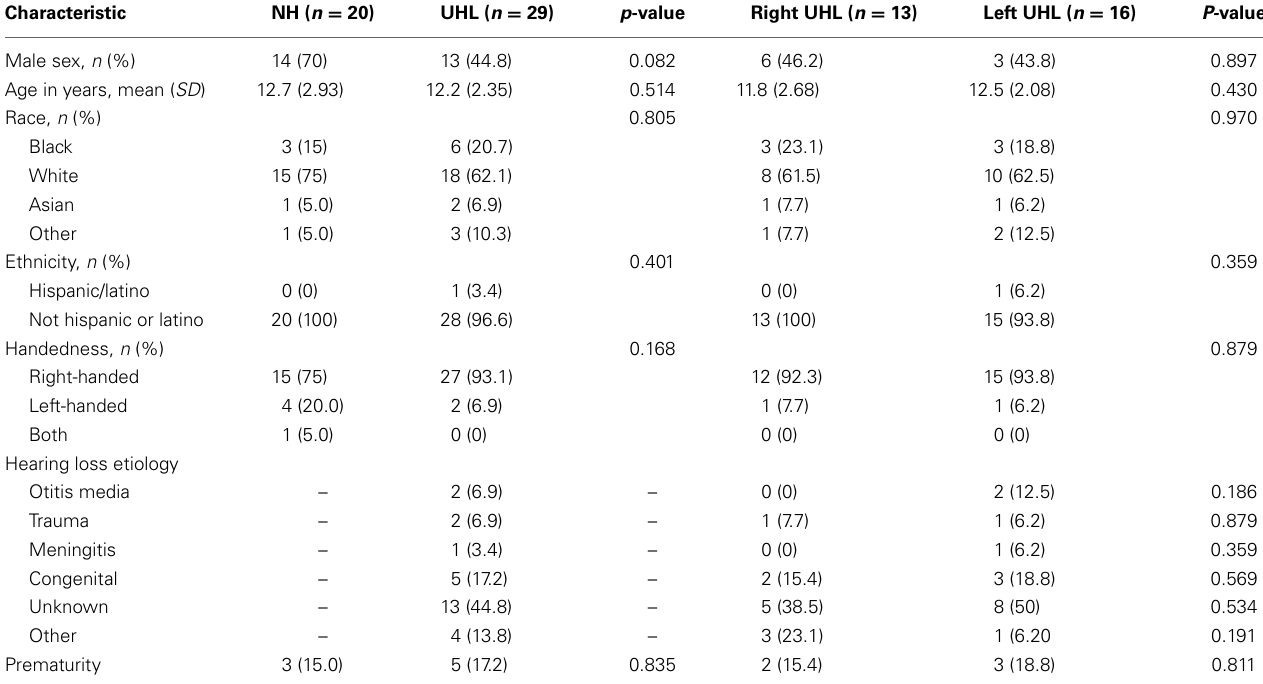
Table 2 | Demographic characteristics of normal hearing (NH) children and children with unilateral hearing loss (UHL).